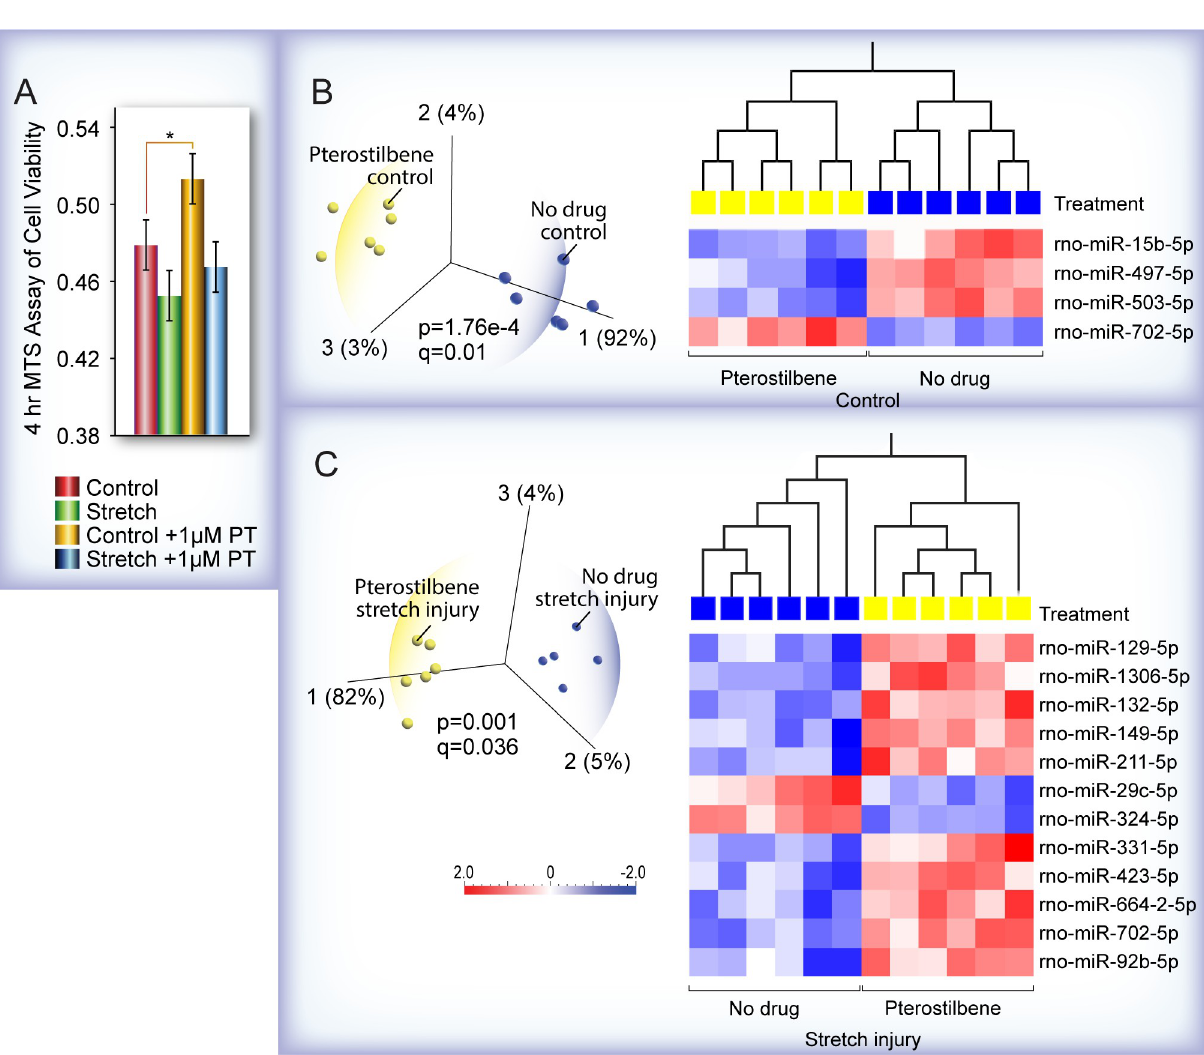
Fig 5. Characterization of the pro-survival effects of pterostilbene (PT) in vitro . (A) PT significantly increased cell viability of unstretched control H19-7 cells ( � p < 0.02). Error bar = SEM, standard error of the mean (B) PCA and hierarchical clustering heatmap analysis of miRNA expression in control cells showed that PT treatment downregulated three miRNAs which are known to target the pro-survival genes Bdnf and Bcl-2. (C) Although PT treatment had no apparent effects on the viability of stretch injured H19-7 cells as measured by the MTS assay, PCA and hierarchical clustering heatmap analysis revealed that PT downregulated two miRNAs (miR-29c-5p, miR-324-5p) whose altered expression could serve as a molecular marker of PT- induced pro-survival effects.